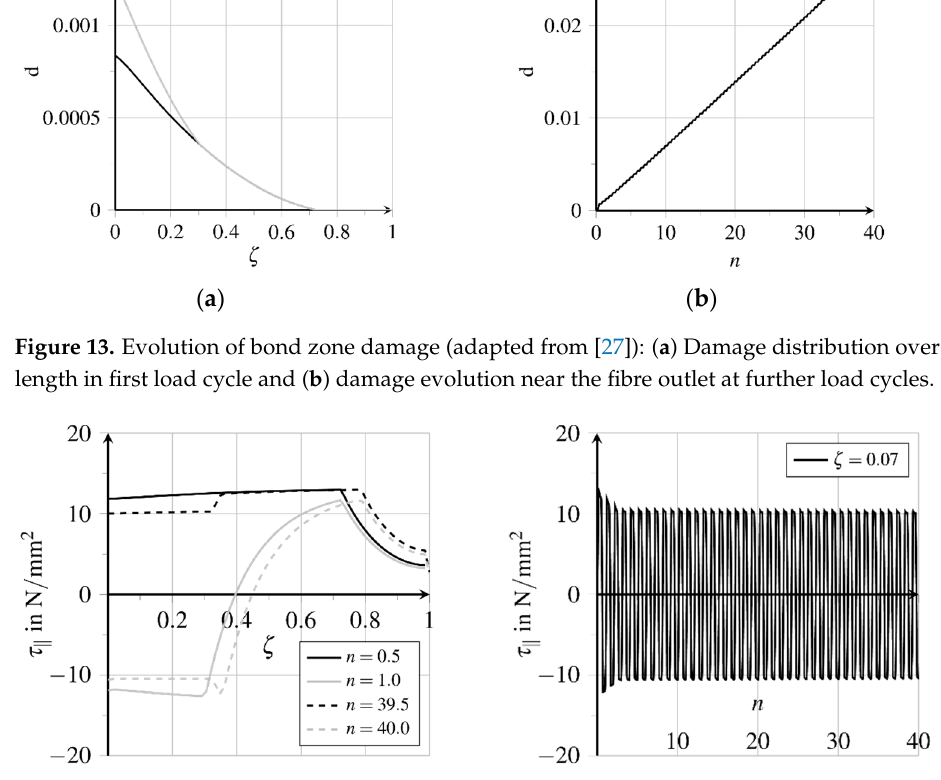
Figure 14. Evolution of bond zone shear stresses (adapted from [27]): ( a ) Stress distribution over bond length in first load cycle and ( b ) stress evolution near the fibre outlet at further load cycles.